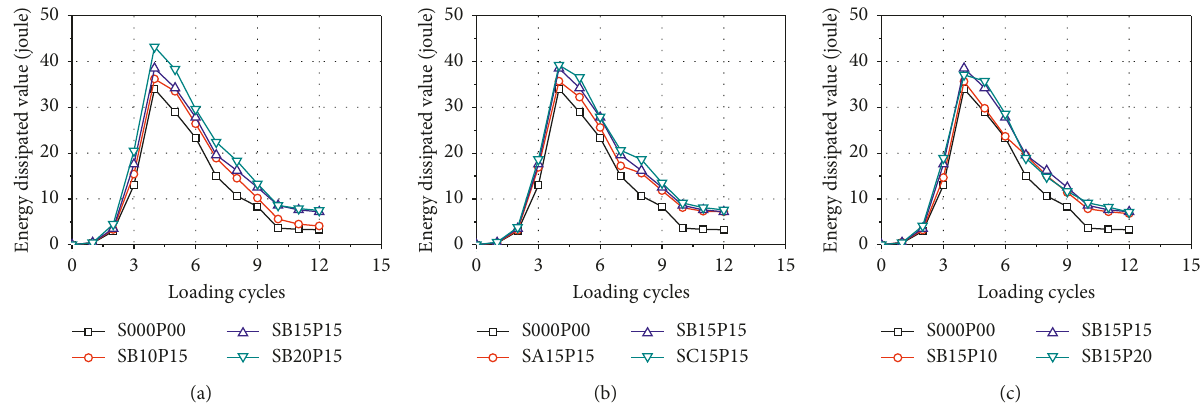
Figure 11: The dissipated energy W pl . (a) Effect of volume fraction of SF. (b) Effect of fiber aspect ratio of SF. (c) Effect of volume fraction of